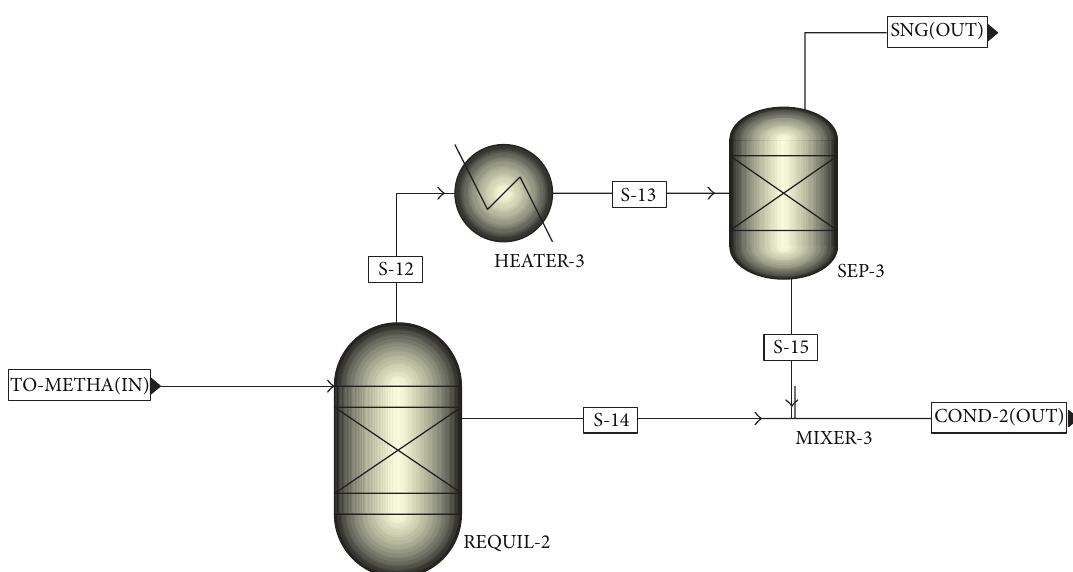
Figure 9: Aspen Plus METHANAT hierarchy diagram to simulate the methanation reaction in the cola-SNG